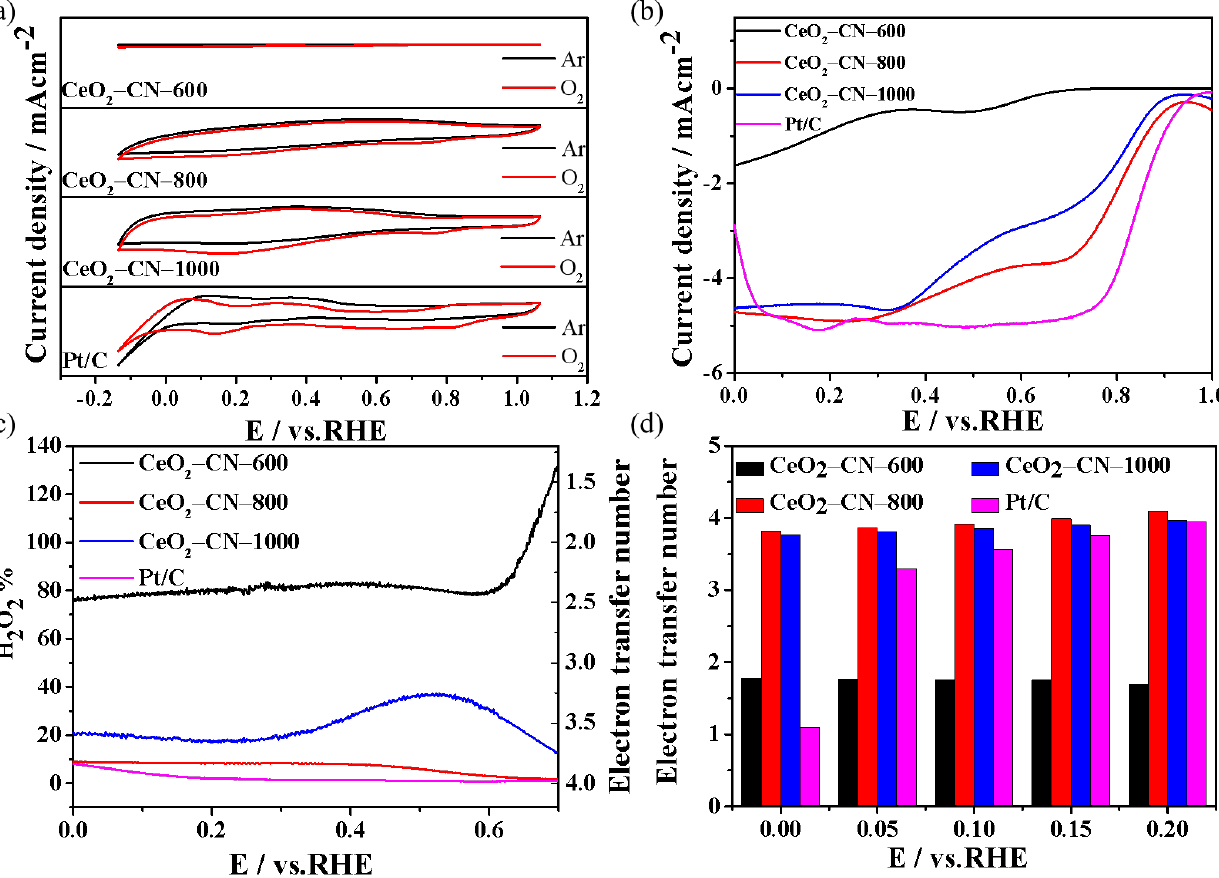
Figure 3. ( a ) CV diagrams; ( b ) LSV curves; ( c ) hydrogen peroxide yields and electron transfer numbers tested using RRDE; ( d ) electron transfer numbers calculated from the K-L curves for CeO 2 – CN – 600, CeO 2 – CN – 800, CeO 2 – CN – 1000, and Pt/C.